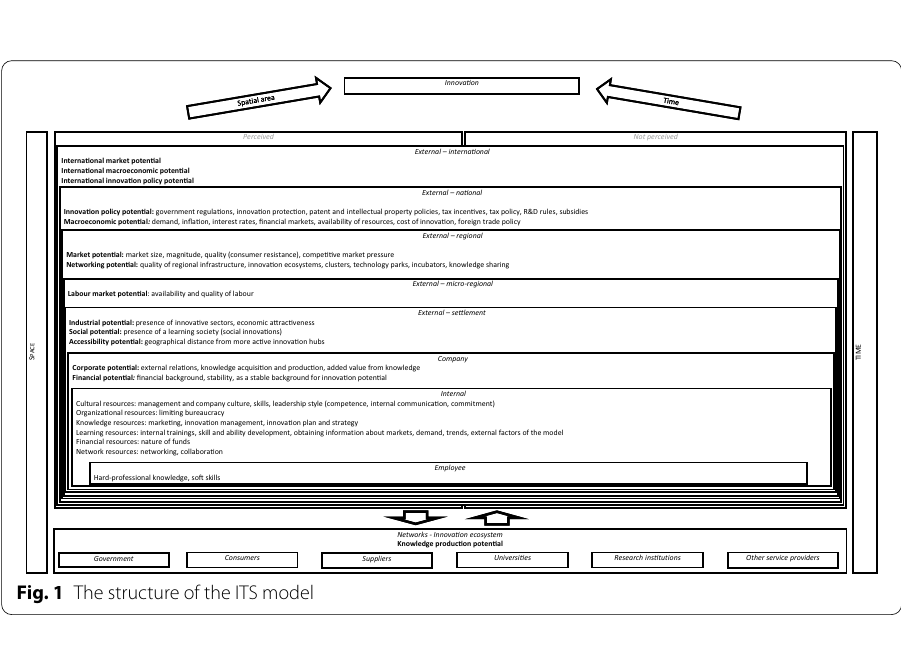
Fig. 1 The structure of the ITS model